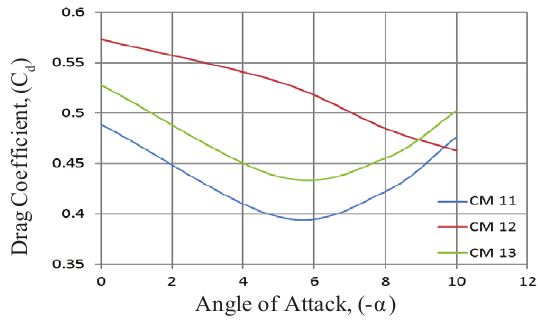
Figure 8. Drag coefficient vs Pitch angle comparison of conceptual